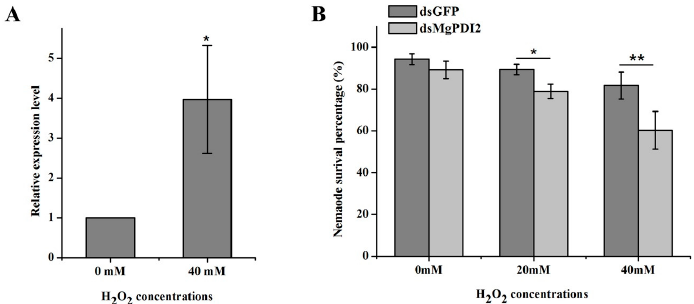
Figure 6. MgPDI2 expression is triggered by H 2 O 2 and increases H 2 O 2 tolerance. ( A ) The relative mRNA expression levels of MgPDI2 in response to the H 2 O 2 stress. ( B ) E ff ect of MgPDI2 silencing on H 2 O 2 stress tolerance. Asterisks indicate significant di ff erences based on Tukey’s test (*: p < 0.05; **: p <